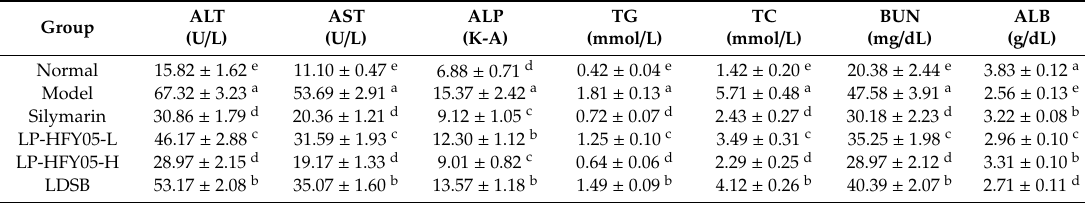
Values are mean ± standard deviation ( N = 10 / group). Sample data in each group come from a normal distribution. The di ff erence in variance between the two groups was significant ( p < 0.05). a–e Mean values with di ff erent letters over the same column are significantly di ff erent ( p < 0.05) according to Tukey’s honestly significant di ff erent test. Silymarin: Mice treated with silymarin (100 mg / kg), LP-HFY05-L: Mice treated with a low concentration of Lactobacillus plantarum HFY05 (1.0 × 10 8 CFU / kg), LP-HFY05-H: Mice treated with a high concentration of Lactobacillus plantarum HFY05 (1.0 × 10 9 CFU / kg), LDSB: Mice treated with Lactobacillus delbrueckii subsp.